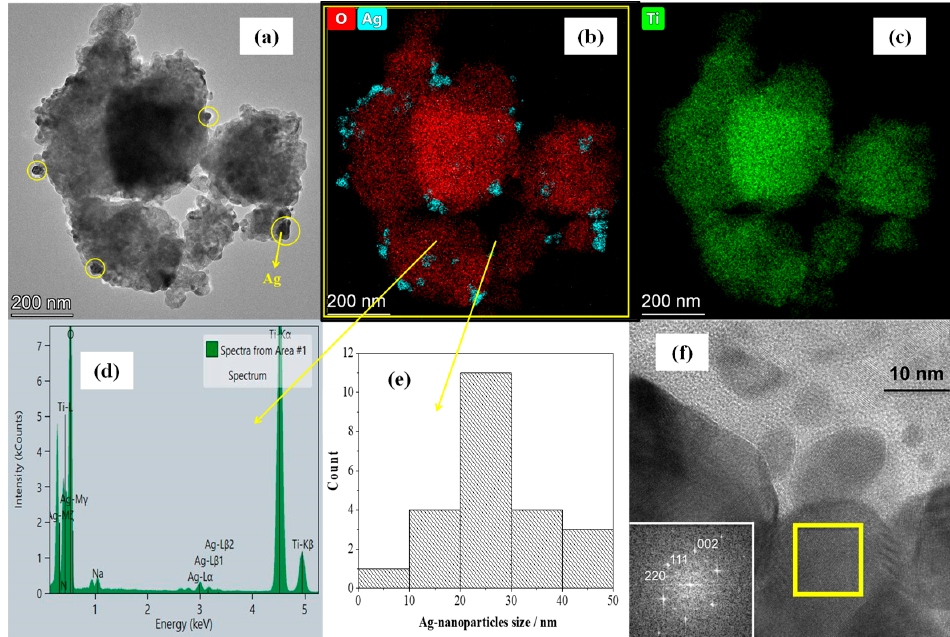
Figure 5. TEM analysis of the Ag/NT-U catalyst (with 10 − 4 mol g − 1 Ag concentrtion); ( a ) TEM micrograph; ( b , c ) element maps obtained in STEM–EDS mode; ( d ) EDS spectrum of the entire aggregate; ( e ) size distribution of Ag nanoparticles; and ( f ) HRTEM image of Ag nanoparticles with an inserted fast Fourier transform (FFT) pattern on the lower left, obtained from the area marked by the yellow square and indexed according to the structure of native silver. Table 1. Characteristic values of the catalysts